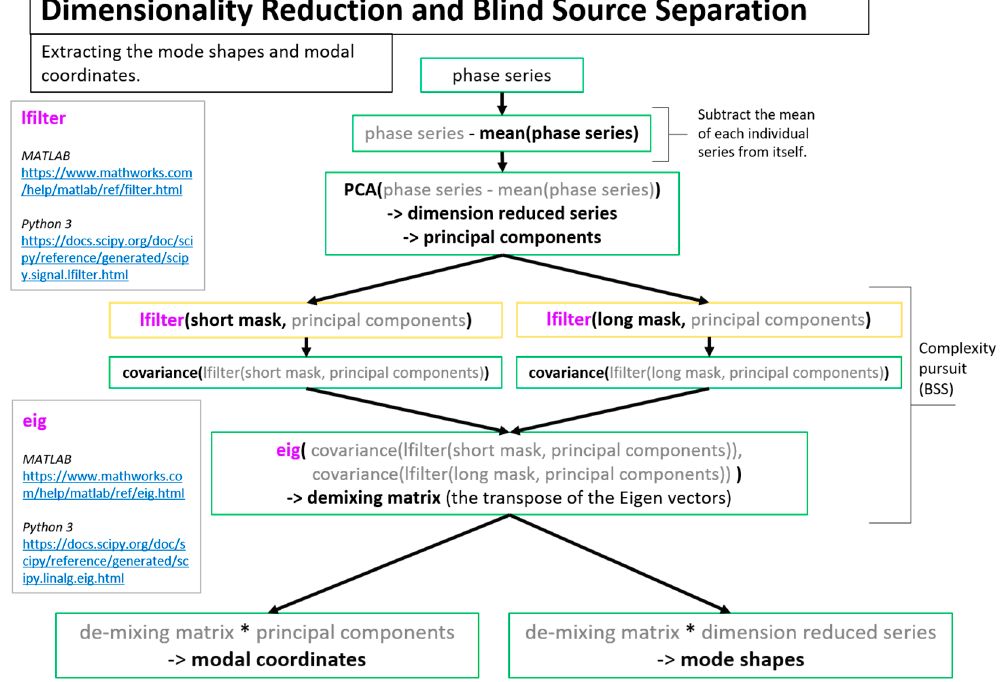
Figure 5. Dimensionality reduction and blind source separation to extract mode shapes and modal coordinates.